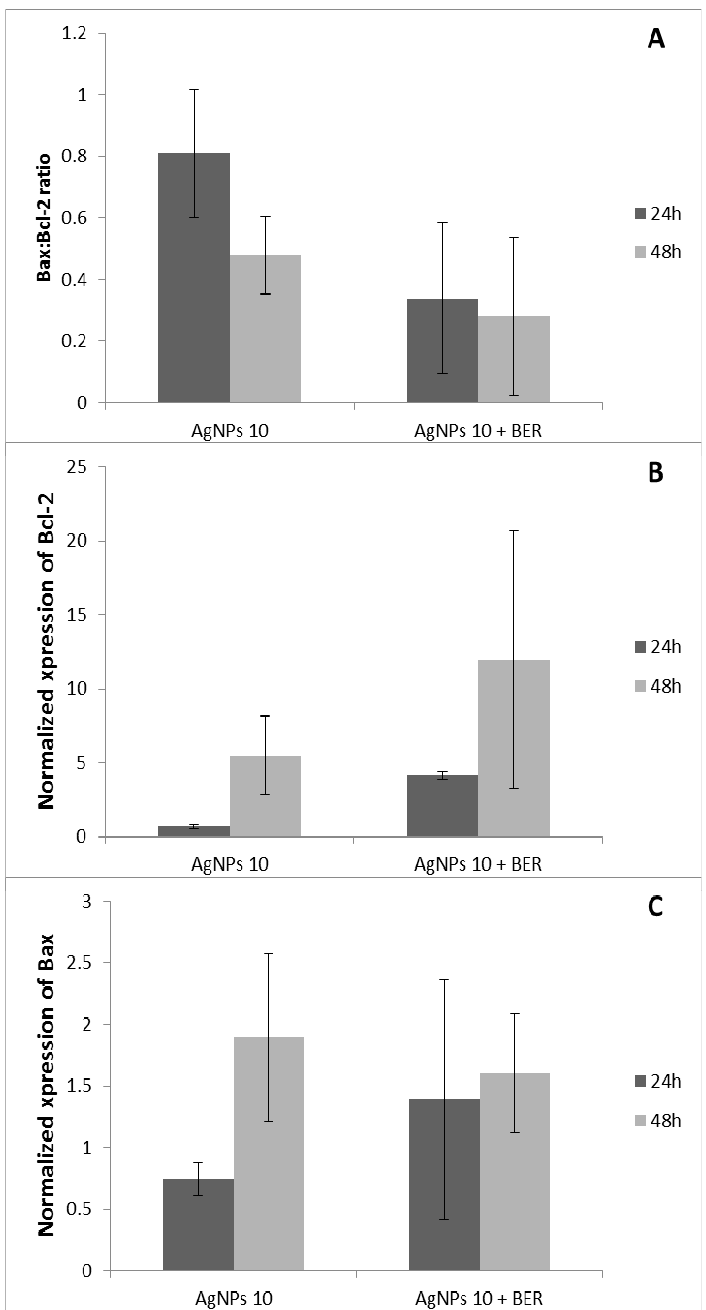
Figure 6. Effect of AgNPs and combined action of AgNPs + BER on the expression levels of apoptosis-related genes Bax/Bcl-2 in SCC25 cells. The expression levels of Bax, Bcl-2 in SCC-25 cells were determined by RT-QPCR assay. Specificity of the reaction of amplification of all fragments of studied genes was assessed by means of polyacrylamide gel electrophoresis. Each sample was examined in two repetitions. ( A ) Representative bar graphs show the expression of relative level of Bax/Bcl-2 ratio, when the cells were treated with AgNPs at 10 μ g/mL and combination of AgNPs/BER for 24 and 48 h ( p < 0.05, ANOVA, AgNPs vs. AgNPs + BER); ( B ) Representative bar graphs show the expression of level of Bcl-2 gene, when the cells were treated with AgNPs at 10 μ g/mL and combination of AgNPs/BER for 24 and 48 h ( p < 0.05, ANOVA, AgNPs vs. AgNPs + BER); ( C ) Representative bar graphs show the expression of level of Bax gene, when the cells were treated with AgNPs at 10 μ g/mL and combination of AgNPs/BER for 24 and 48 h.